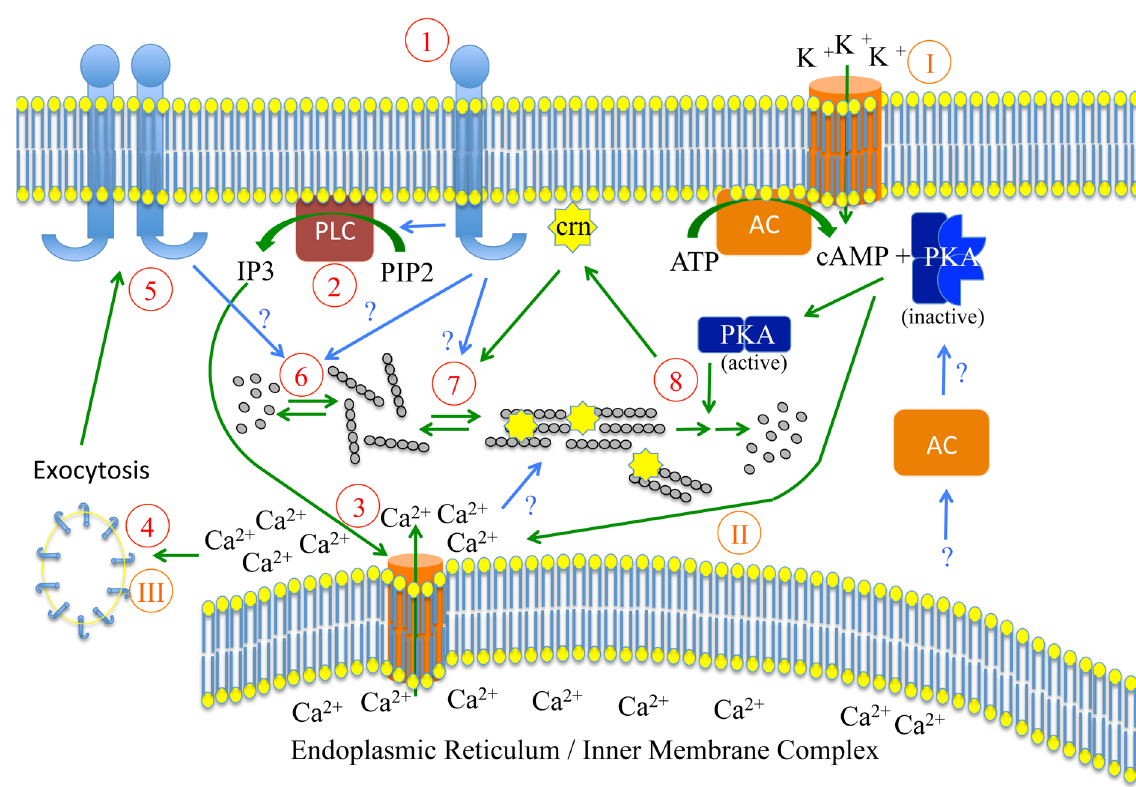
Fig 6. Speculative working model on coronin function at the interface between calcium and cAMP signaling during motility (red Arab numbers) and invasion (orange Roman numbers). Upon activation of a trans-membrane receptor by extracellular ligands on the salivary gland or in the skin (1), phospholipase C is activated and converts PIP2 into IP3 (2). This leads to the release of calcium from intracellular stores (3) and subsequent exocytosis of micronemes, which bring more receptors to the plasma membrane (5). These reinforce signaling and activate actin polymerization (6). Actin filaments are organized by surface receptors and relocalization of coronin from peripheral membranes (either PM or IMC) to actin filaments (7). This leads to efficient adhesion and force production essential for motility in 2D. Coronin (crn) relocalizes from actin filaments as these are disassembled through the action of PKA, which is possibly activated by cytosolic adenylate cyclase (AC). Upon stimulation of membrane bound adenylate cyclase more cAMP is produced leading to higher PKA activity and further calcium release from intracellular stores. The additionally released receptors then mediate